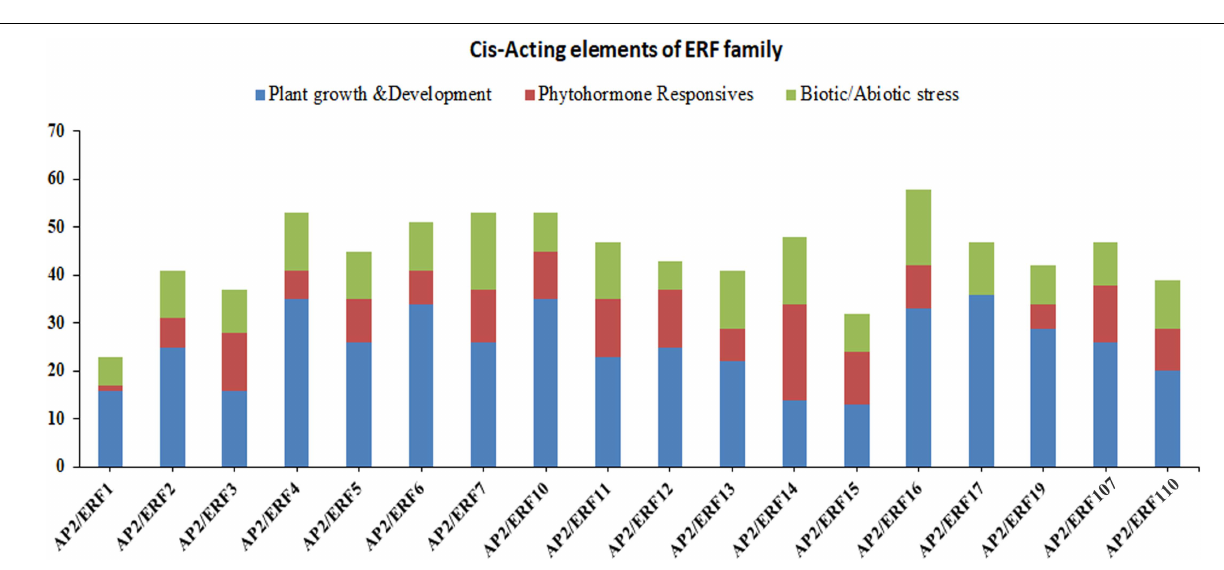
Frontiers in Genetics |